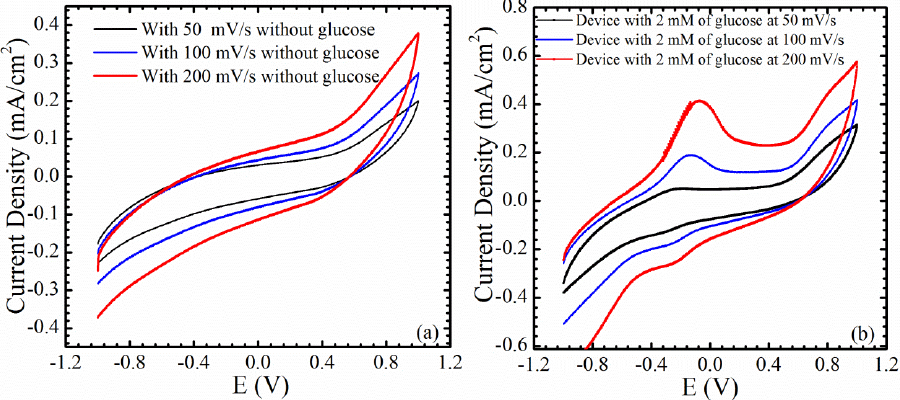
Figure 9. Cyclic voltammetry of the fabricated Si/SiO 2 /Au/ZnO NRs/GO x /Nafion with and without glucose at different scanning rates, 50, 100, 200 mV/s. ( a ) Absence of glucose; ( b ) Presence of glucose.